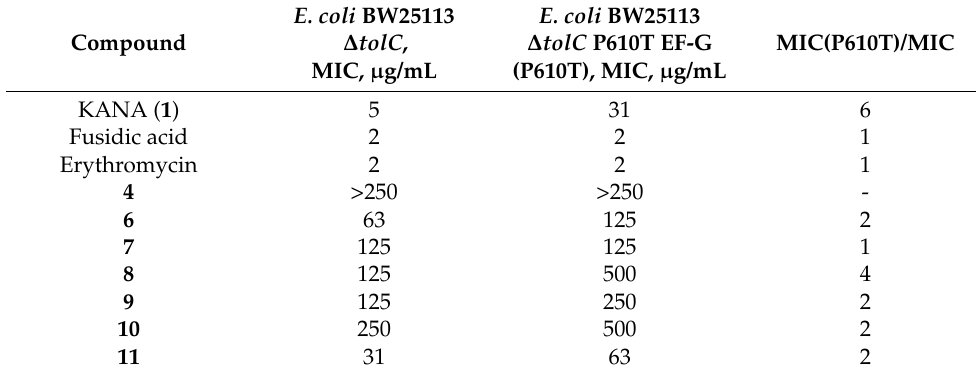
Table 2. Antibacterial activity of the KANA derivatives 4 , 6 – 11 against E. coli BW25113 ∆ tolC strain and its derivative with mutated fusA